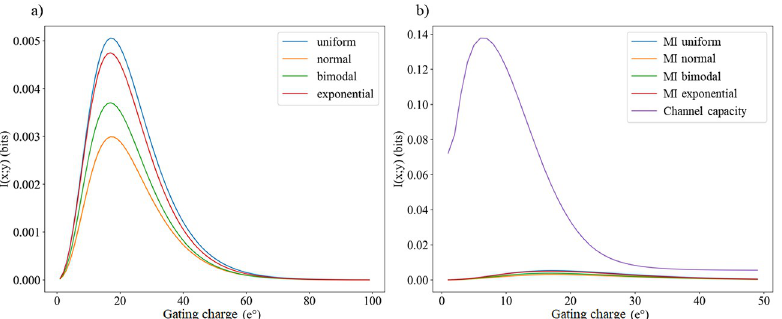
maximizes channel capacity as well. The x (environment) ranges from 0 to 20 mM, intervals are taken each 0.5 mM, mean = 10, second mean (only for bimodal) = 3, std. deviation (for normal and bimodal) = 5. Max. mutual information values are 0.0052 (uniform), 0.0048 (exponential), 0.0037 (bimodal), and 0.0029 (normal) bits. Maximum mutual information (channel capacity) is